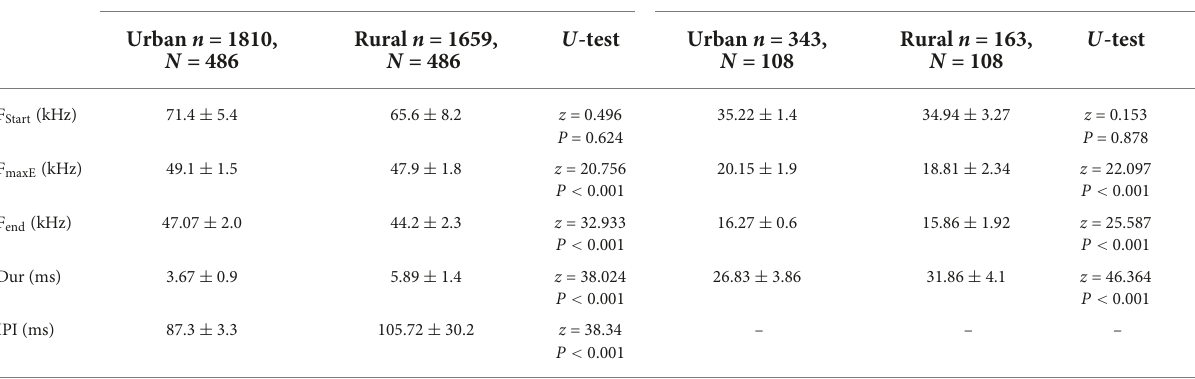
TABLE 1 Mean ± SD for time and frequency variables of echolocation and social calls of urban and rural Pipistrellus pipistrellus with probability level for significance of differences (Mann–Whitney U -test). Echolocation calls ( n = 3469 calls, N = 972